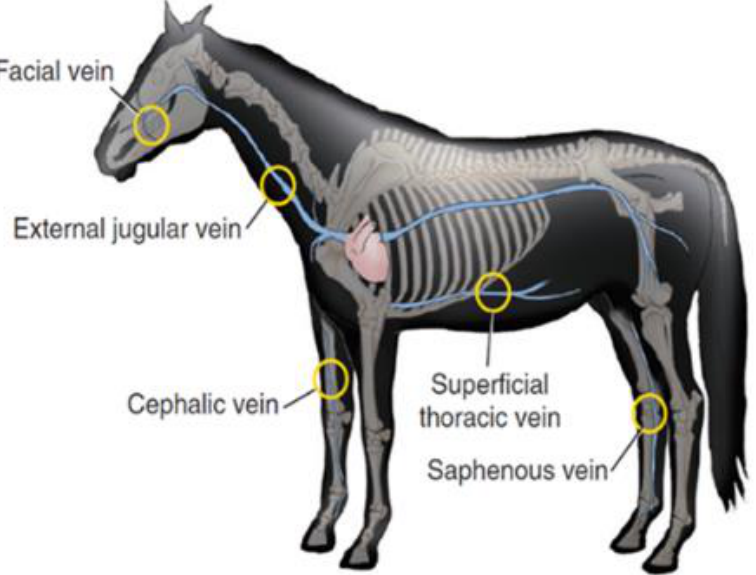
Figure 4. Anatomical sites for equine intravenous administration, including jugular, superficial thoracic, facial, cephalic, and saphenous veins. Reprint with permission from Orsini [124]. 2022, Elsevier.